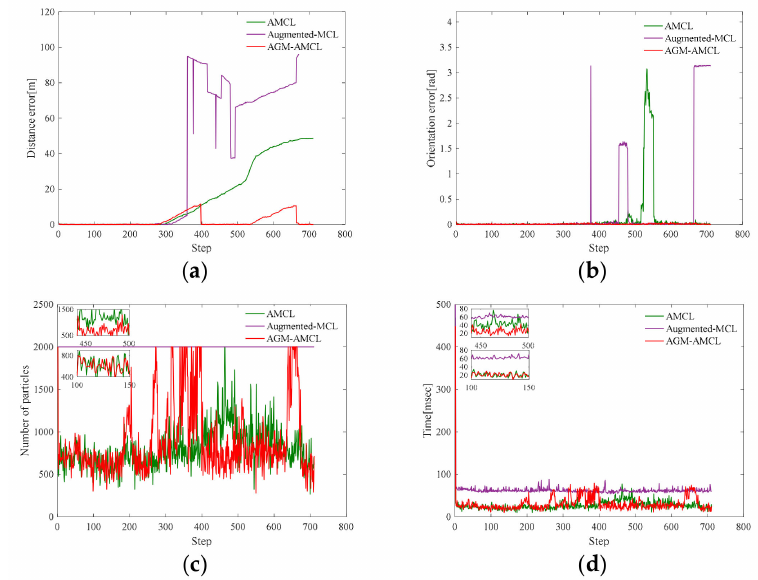
Figure 13. Localization results in scene A: ( a ) distance error; ( b ) orientation error; ( c ) number of particles; ( d ) running time. Note that the orientation errors of AMCL are small in most times. This is because the orientation can be easily determined in the long corridor while it will cause large distance error. The running time of our method is similar to AMCL in unambiguous areas (the zoomed result from step 100 to 150). Our method is more e ffi cient than AMCL after the robot moving through an ambiguous area (the zoomed result from step 450 to 500). Our method needs more particles when the robot is in an ambiguous area and near an unambiguous area (step 300 to 400), therefore it is less e ffi cient than AMCL. Because of the fixed particle number, augmented-MCL takes more time than the other two methods in most